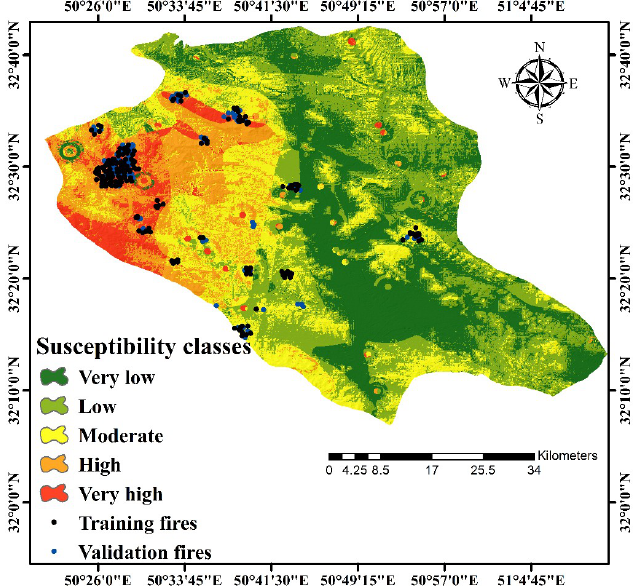
Figure 12. Fire susceptibility mapping (FFSM) using the ANFIS-GA-SA model.